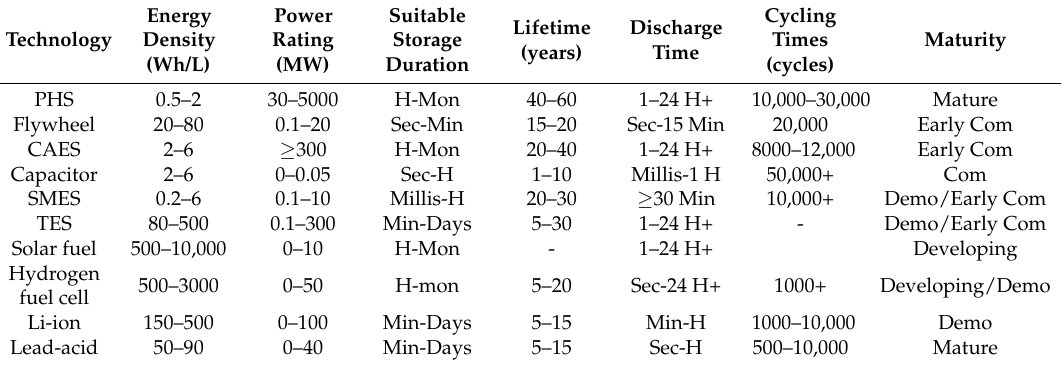
Table 1. Technical characteristics of electrical energy technologies [6–10].